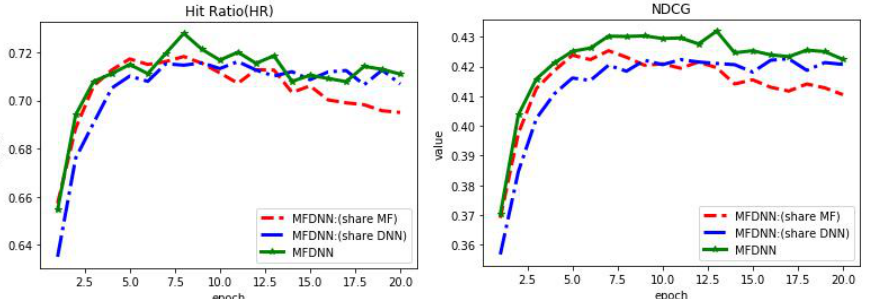
Figure 12. The HR and NDCG values for MFDNN: (share MF), MFDNN: (share DNN), and MFDNN.